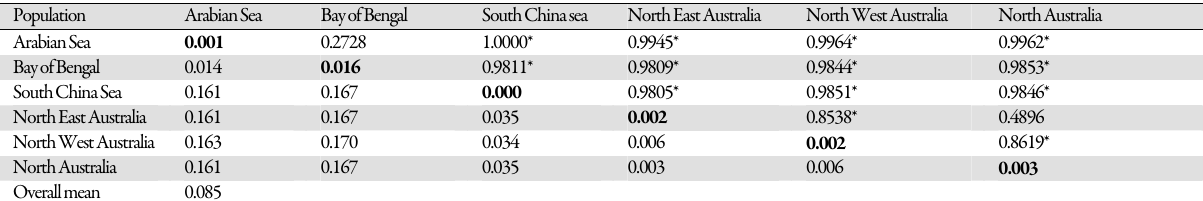
Fig. 3. Median-joining network for the COI haplotypes in E. Fig. 4. Mismatch distribution of COI haplotypes in E. tetradactylum populations. (A-Arabian Sea; B-Bay of Bengal; C-North West Australia; tetradactylum populations. Each circle represents a unique haplotype, D-North Australia; E-North East Australia; F-Overall with the area being proportional to the frequency of the haplotypes Table 3. K2P genetic distance between populations (below diagonal), within populations (bold) and pairwise F st values (above diagonal) for COI sequences in E. tetradactylum